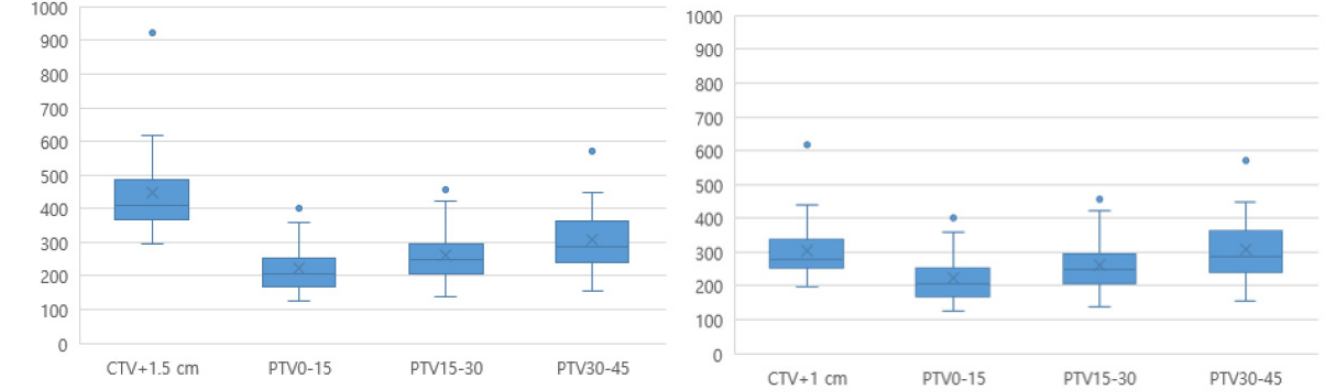
Figure 3. Comparison of the ART-PTV with the conventional PTV. ART, adaptive radiotherapy; CTV, clinical target volume; PTV, planning target volume.